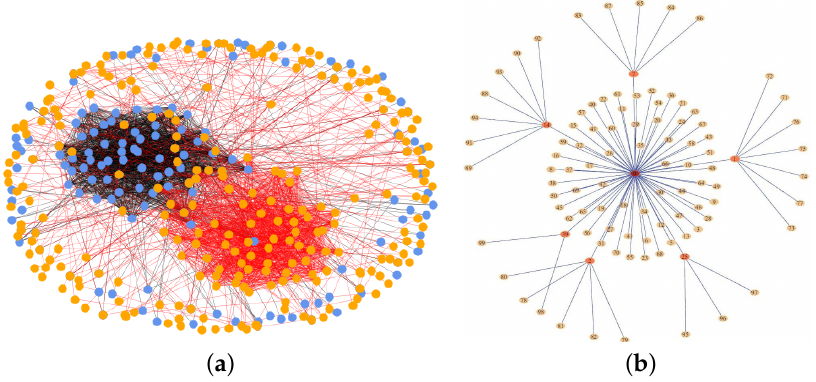
Figure 2. Connectivity structure graph: ( a ) brown-field case study and ( b ) literature